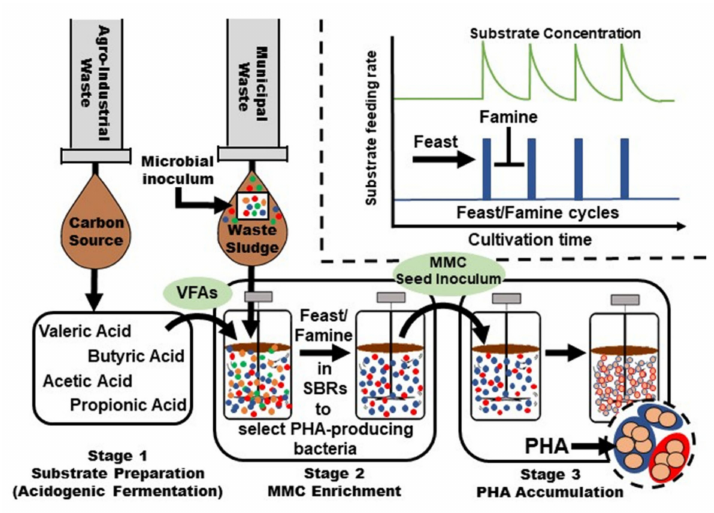
Figure 6. The use of mixed microbial consortia (MMC) for PHA